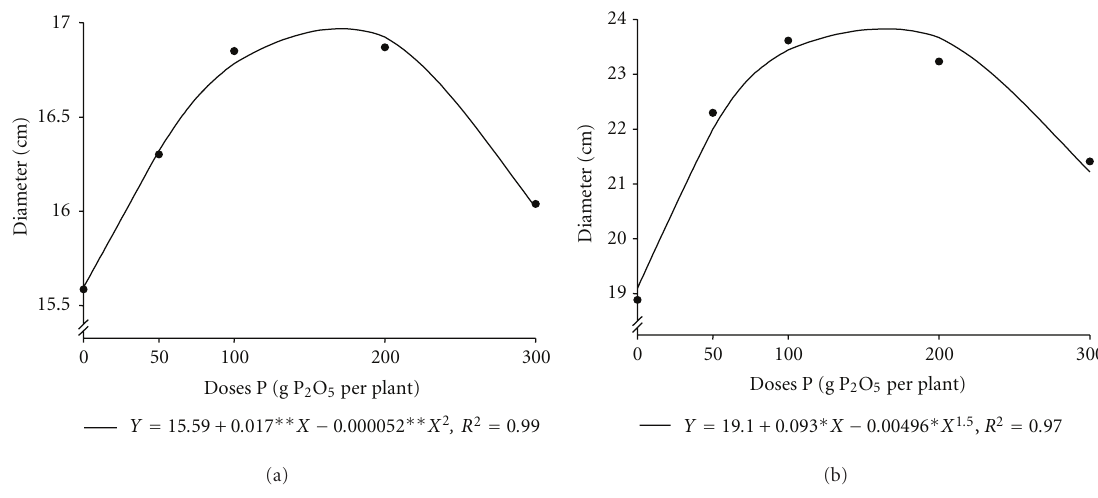
Figure 1: E ff ect of phosphorus applied at planting on lychee plants stem diameter at the first (a) and second (b) year after planting. ∗∗ Significant P < 0 . 01 and ∗ significant P < 0 .